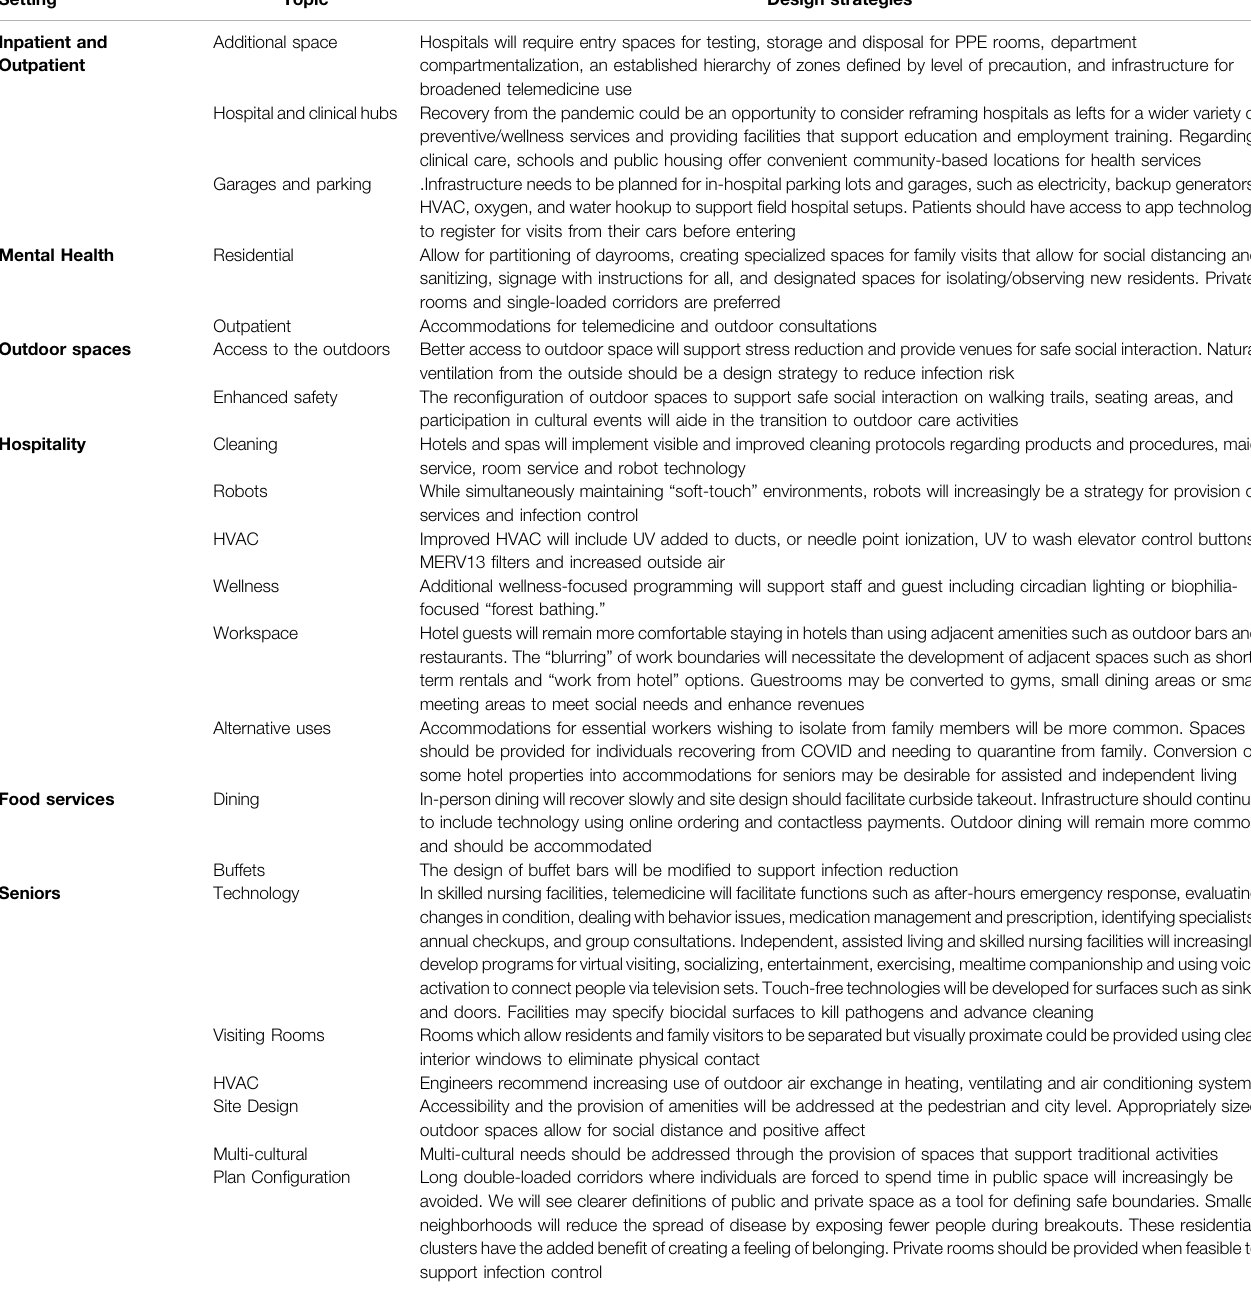
TABLE 1 | Primary design